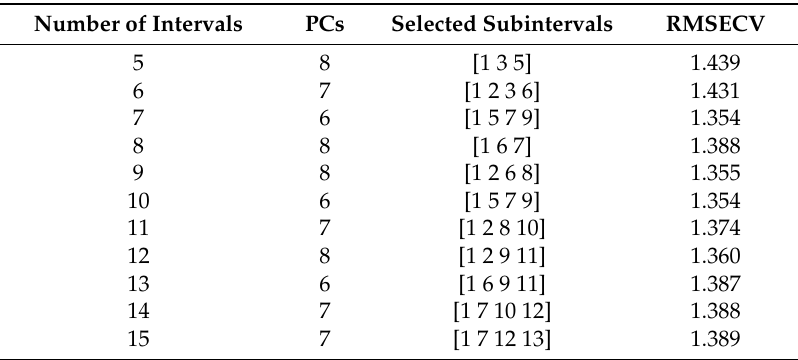
Table 3. The results of selected optimal spectral subintervals.